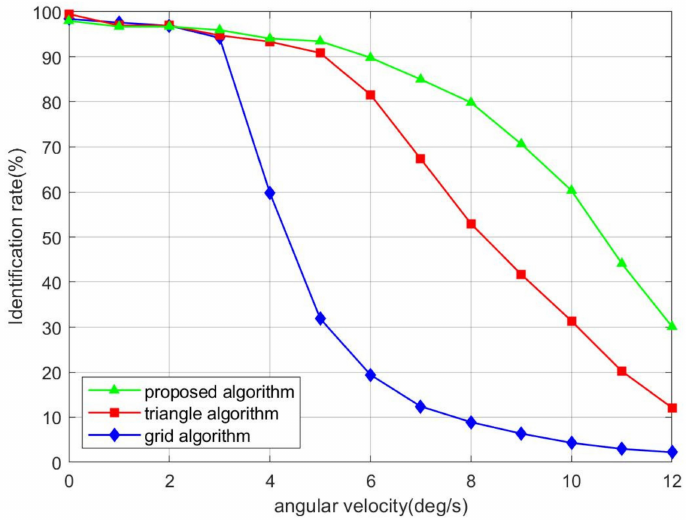
Figure 8. Identification rate for smearing star images at different three-axis resultant angular